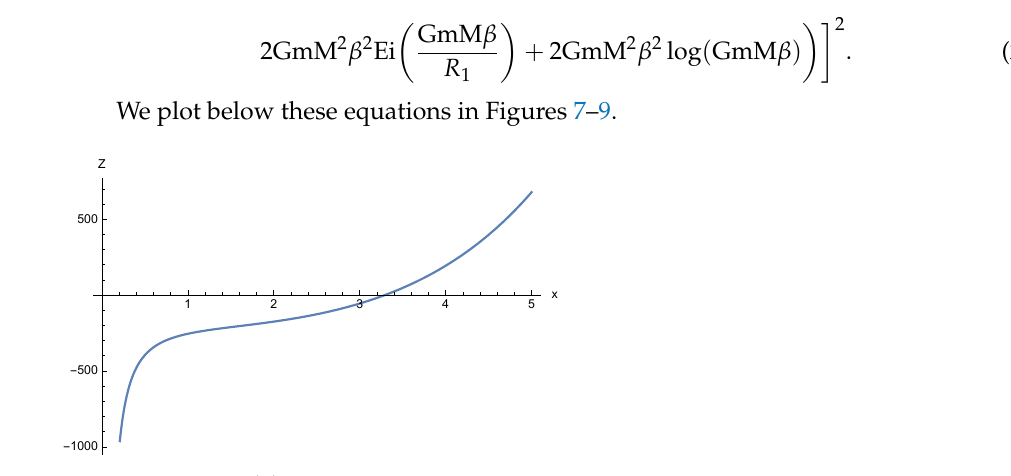
Figure 7. Plot of Z ( x ) versus x = β for G = m = R 1 = M = 1. Results are unphysical for x < 3.35. At the ensuing very high (big-bang like) temperatures (at which matter does not exist), Z ( x ) is negative, and thus unphysical.